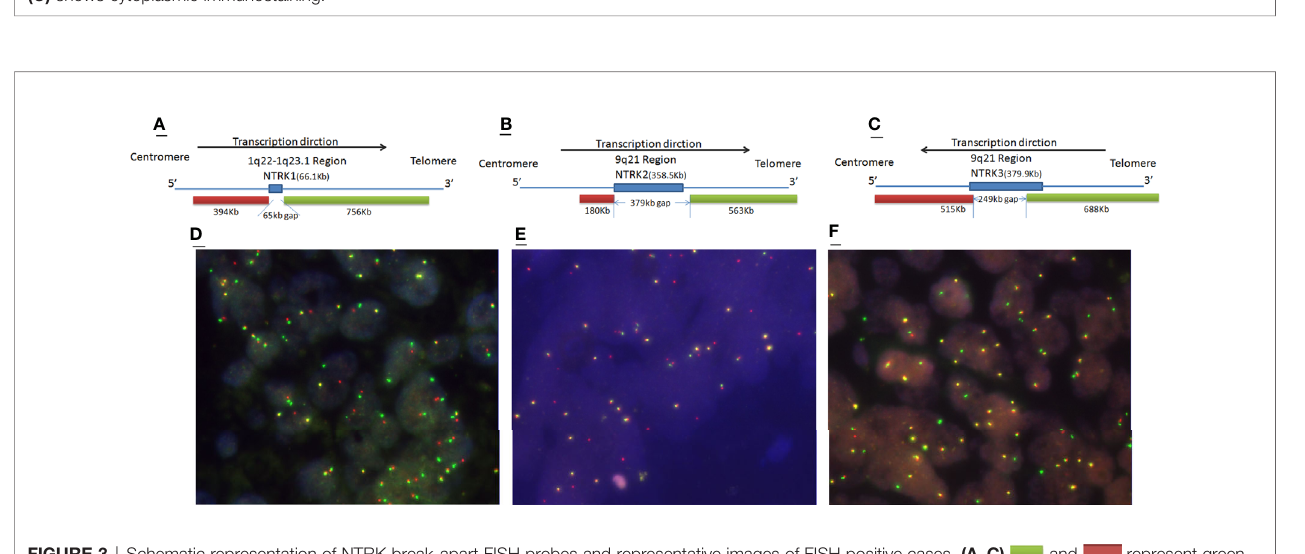
FIGURE 3 | Schematic representation of NTRK break-apart FISH probes and representative images of FISH positive cases. (A – C) and represent green and red fl uorescence probes respectively. (D) Break-apart (1red1green1fusion) signal, (E) red signal, (F) green